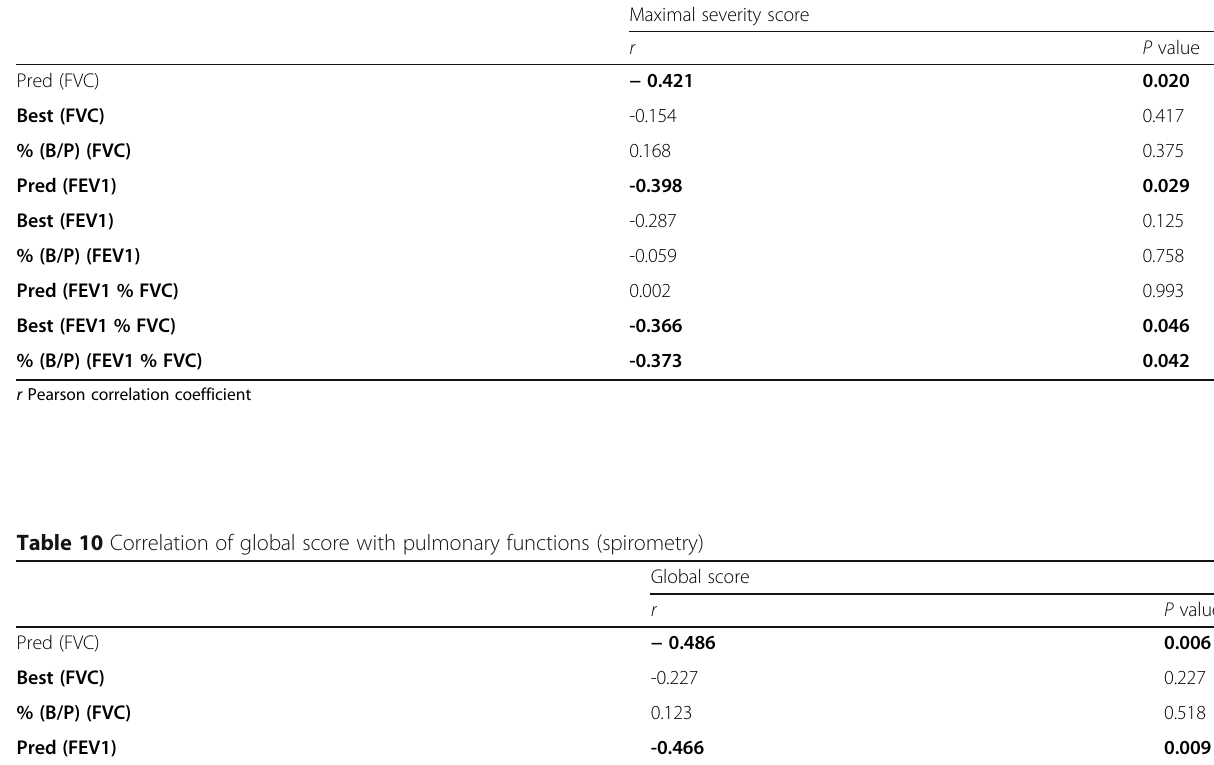
Table 9 Correlation of maximal severity score with pulmonary functions (spirometry)